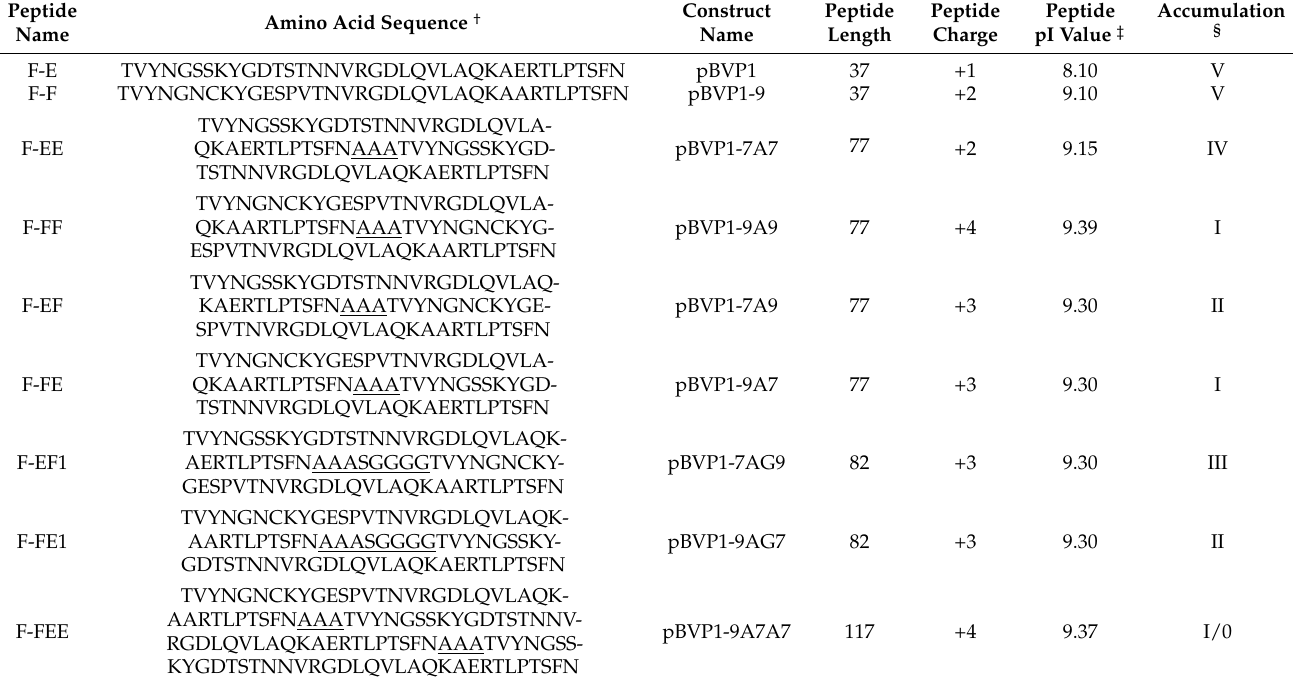
Table 1. List of the N-terminal heterologus peptides of the chimeric BaMV CP putatively encoded by each